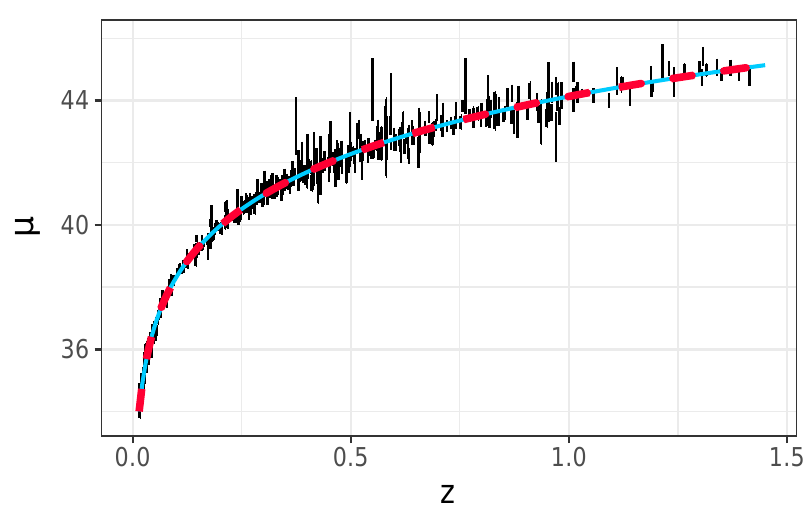
Figure 2: The redshift z plotted versus distance modulus µ for the SN 1a data together with the fits for the Λ CDM model (solid blue line) and the w CDM model (dashed red